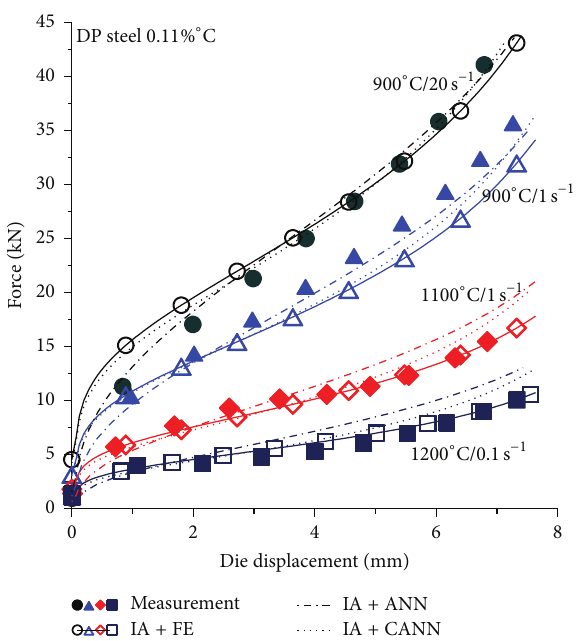
Figure 20: Loads measured in the tests (full symbols) and predicted by the FE code with flow stress calculated from (4) with coefficients determined using classical inverse analysis with the FE model (solid lines) and the two metamodels (ANN and